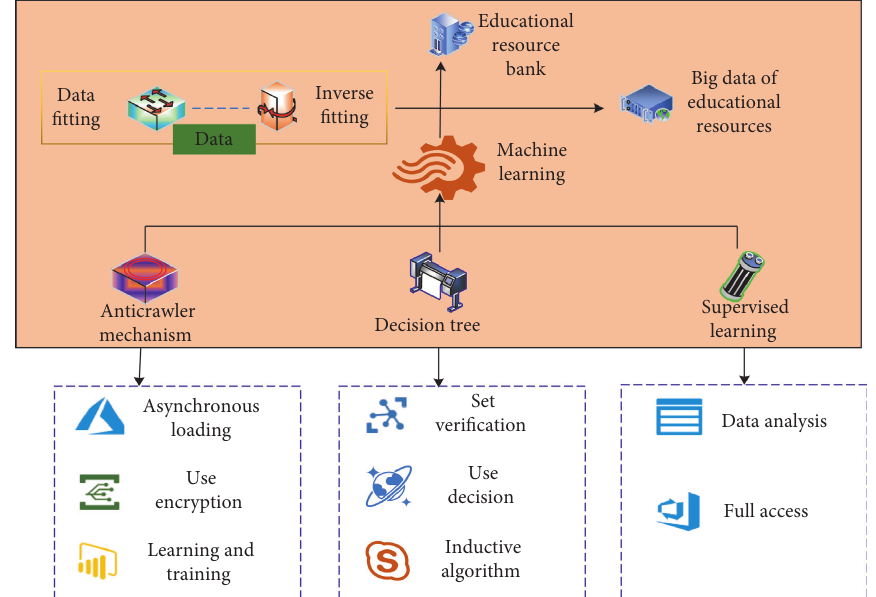
Figure 6: Design of protection technology framework of educational resources based on machine